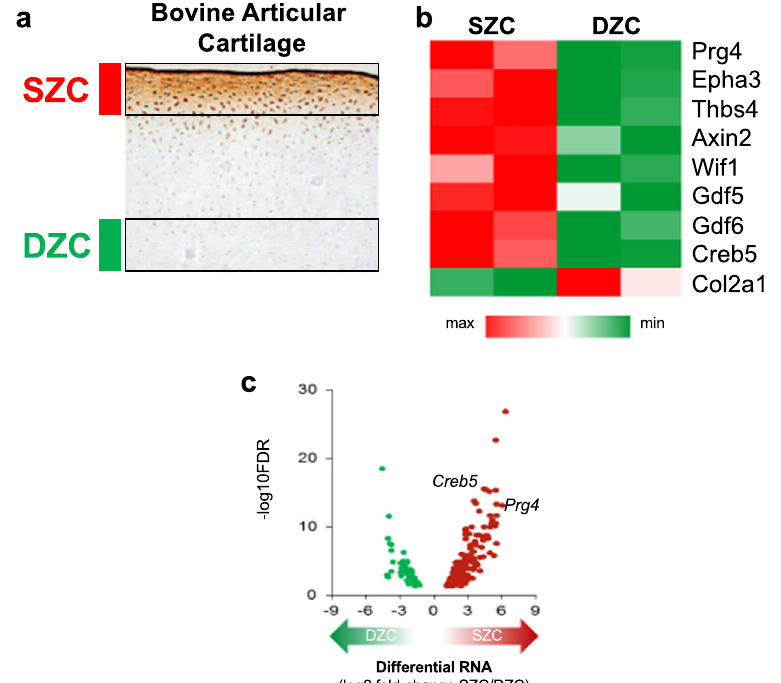
Fig. 1 Identi fi cation of genes that are differentially expressed in super fi cial versus deep zone articular chondrocytes. a Lubricin (brown) is expressed in super fi cial zone chondrocytes (SZCs; adjacent to red bar) and not in deep zone chondrocytes (DZCs; adjacent to green bar) in bovine articular cartilage. Image of lubricin immunostaining taken from 44 . b Relative expression of genes that are differentially expressed in super fi cial zone bovine articular chondrocytes (SZC) versus deep zone bovine articular chondrocytes (DZC). Maximal and minimal expression levels in SZCs and DZCs are indicated by the intensity of the red and green hues, respectively. c Volcano plot of differentially expressed genes (DEGs) in SZCs and DZCs. Each dot represents one gene. The red dots represent SZC-speci fi c DEGs, the green dots represent DZC-speci fi c DEGs. Note that the TF gene Creb5 was as differentially expressed as Prg4 , with ~25-fold higher levels in SZCs than in